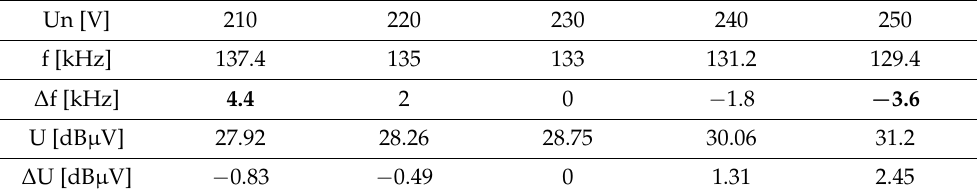
Table 2. Parameters of the selected dominant emission band for the set of lamps (CFL 20 W + LED 7 W) for various supply voltage